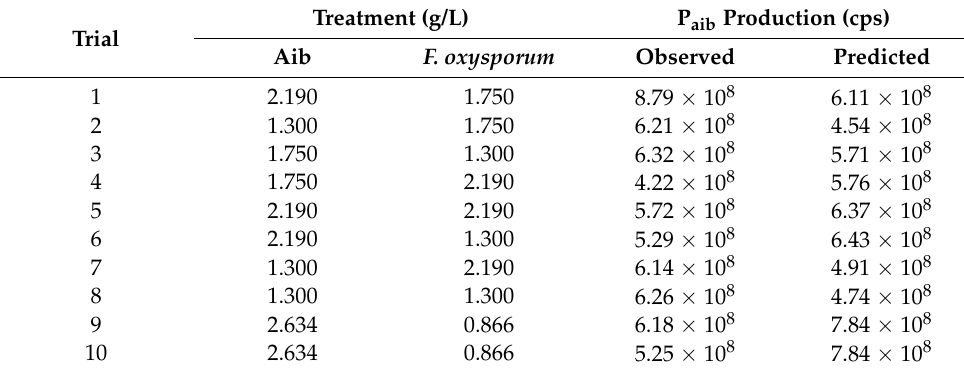
Table 4. Observed and predicted values for P aib production for each experiment for the validation of the central composite model that evaluates the concentrations of Aib and F. oxysporum